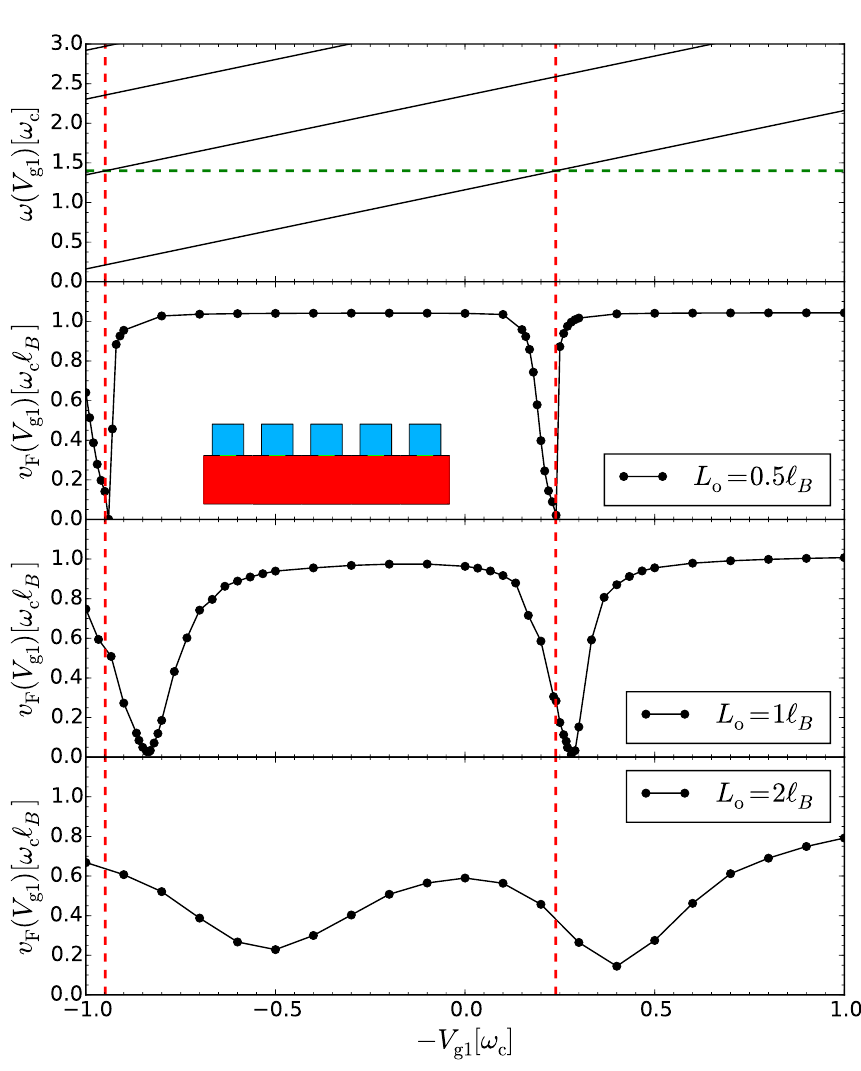
Figure 14: Upper panel: The horizontal dashed line shows the set Fermi level while the slanted solid lines depict the energy level in the isolated bays shifted by the gate voltage. The vertical red lines are guides to the eye to link the resonance visible in the upper panel to the strong response in the lower three panels. Lower three panels: Fermi velocity v as function of the F = 3 µ m, L = 10 µ m, L = 4.01 µ m, (cid:96) = 1 µ m, and the three different gate voltage V for L y x p B g1 b = 1 µ m as values of L o